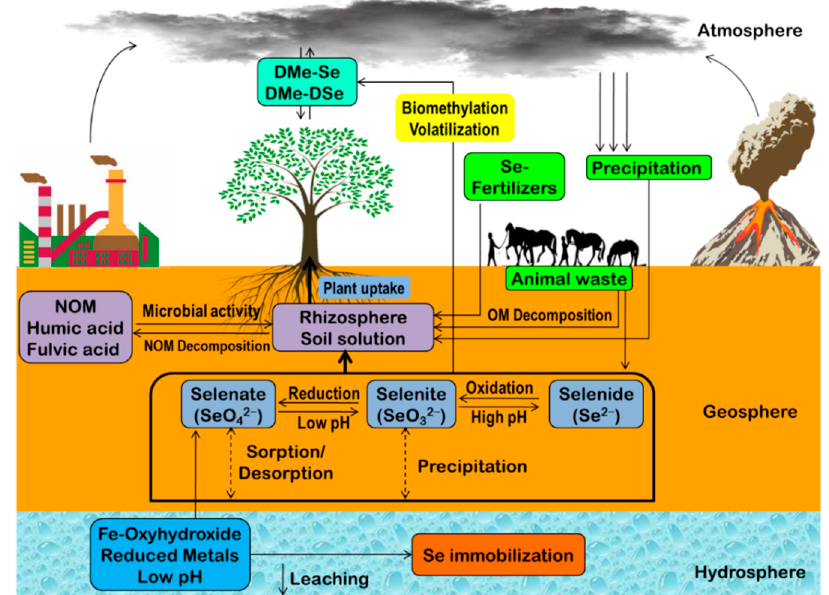
Figure 1. The schematic diagram for the mechanisms of Se-biogeochemistry in different Earth’s compartments. DMe-Se—dimethyl selenide; DMe-DSe—dimethyl diselenide; NOM—natural organic matter, OM—organic matter.